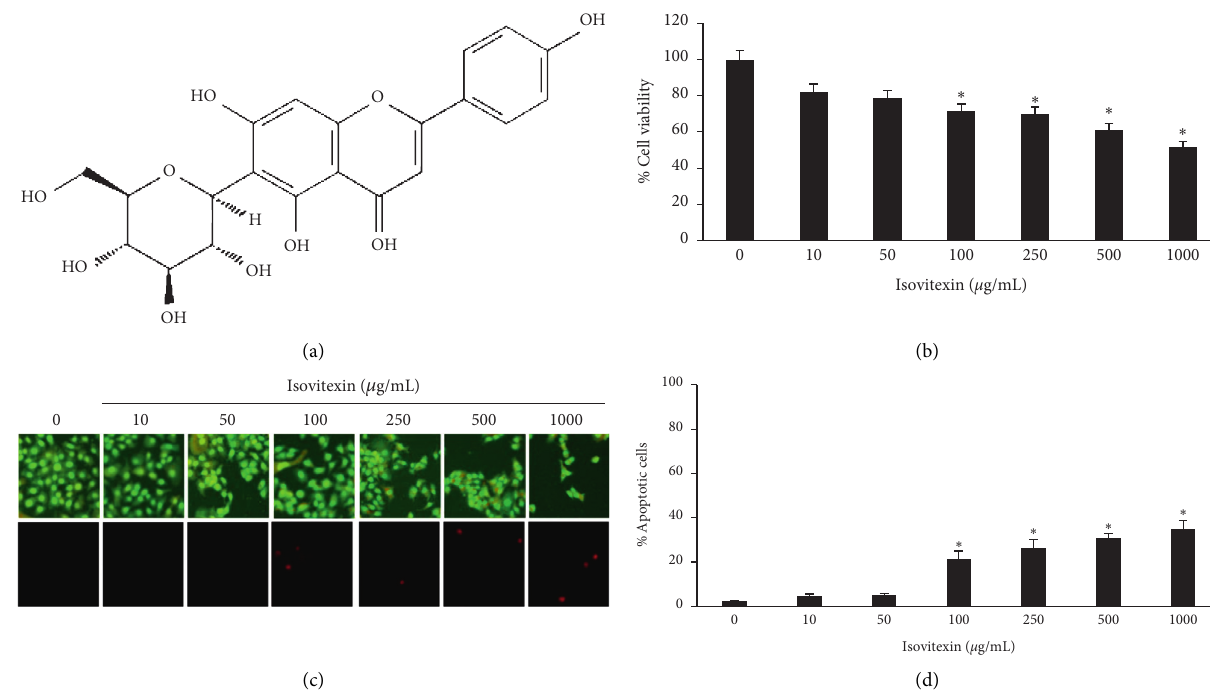
Figure 4: (a) Structure of isovitexin. (b) Cell viability of human breast cancer MCF-7 cells after treated with isovitexin at 0–1000 μ g/mL for 24h. Cell viability was determined by MTTassay. (c) Apoptotic and necrotic cell death were analyzed by acridine orange/propidium iodine costaining assay after 24h isovitexin treatment. (d) Percentages of apoptotic cells were analyzed. Data represent the mean ± SD ( n � 3). ∗ Significantly different at p < 0 . 05 versus nontreated